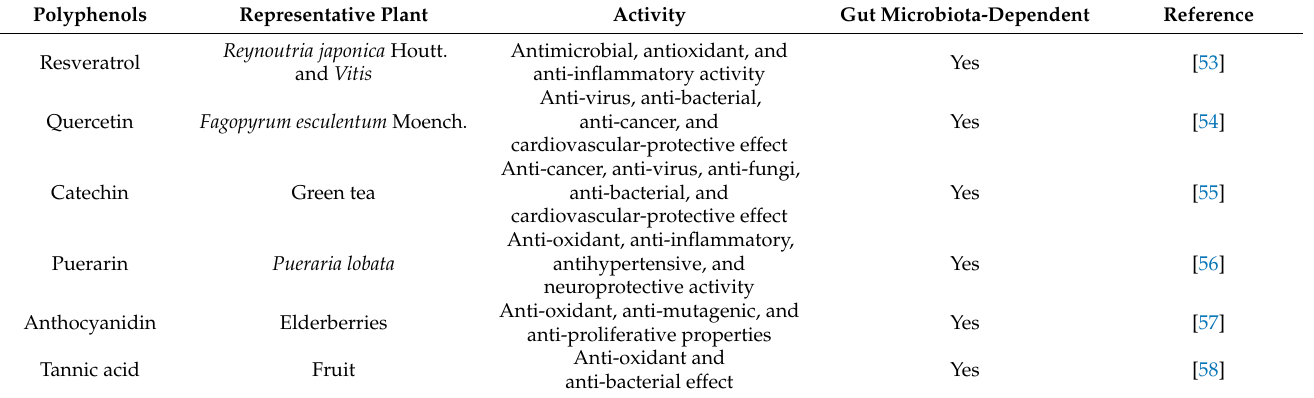
Table 2. Other reported major classes of polyphenols extracted from plants and their activities.